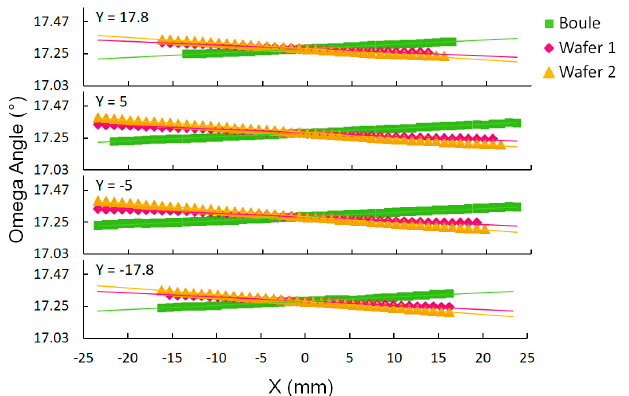
Figure 4. 002 reflection ω peak angle values plotted as a function of position on the wafer. Global curvature is calculated from the slope of each line. The more horizontal the line is, the flatter the crystal lattice. The boule was measured on the nitrogen polar face, and the wafers were measured on the gallium polar face.